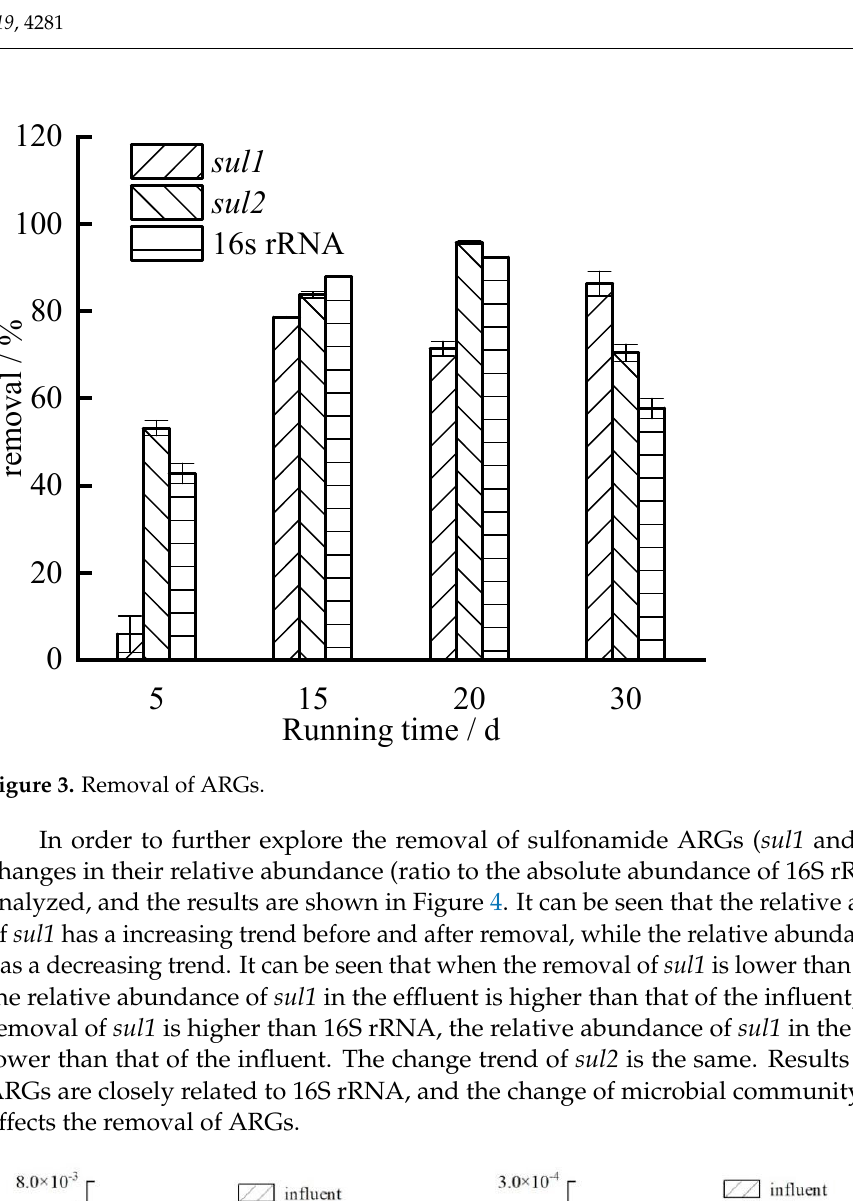
Figure 4. Relative abundance of sulfonamide ARGs.